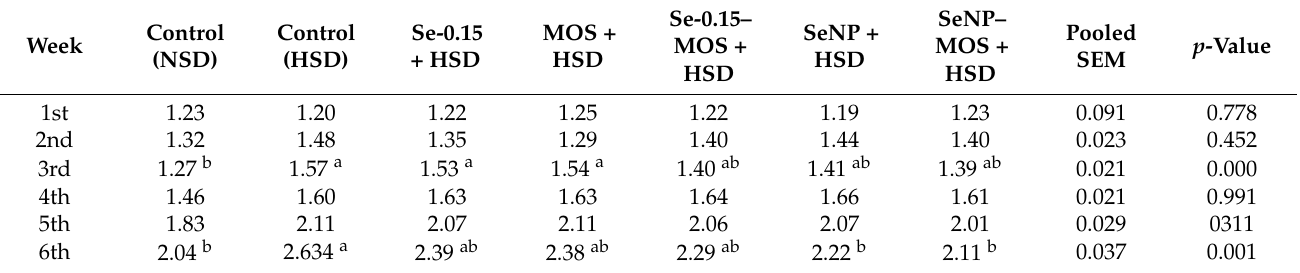
Table 4. Effect of selenium nanoparticles–MOS on FCR of broiler chickens reared under higher stocking density.